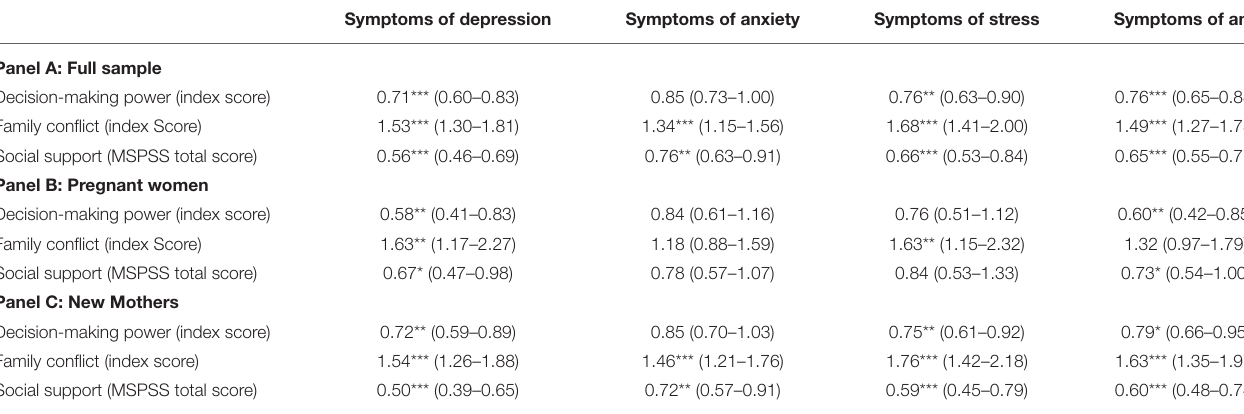
TABLE 4 | Logit regression of associations between social risk factors and perinatal depression, anxiety and stress symptoms. Symptoms of depression Symptoms of anxiety Symptoms of stress Symptoms of